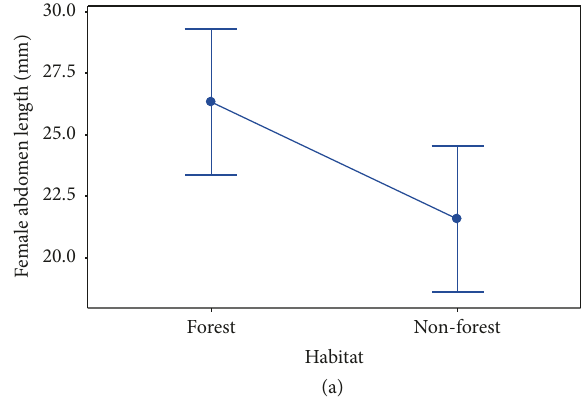
Figure 5: Variation in female abdomen size in N. pilpes occupying forest and nonforest